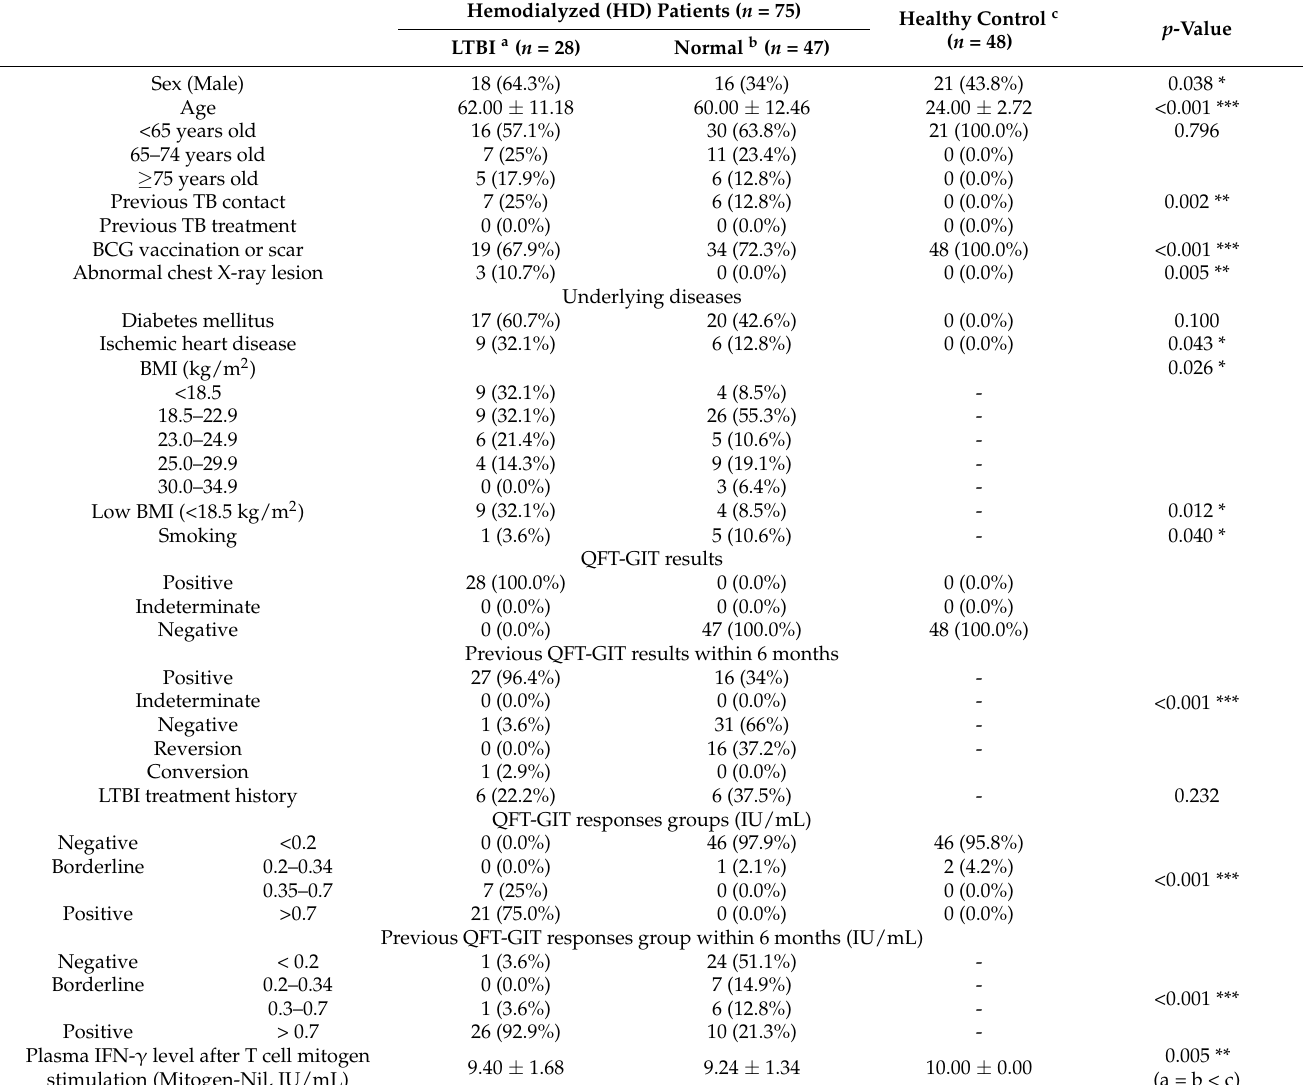
Table 1. Demographics and clinical characteristics and QuantiFERON-TB Gold In-Tube (QFT-GIT) response